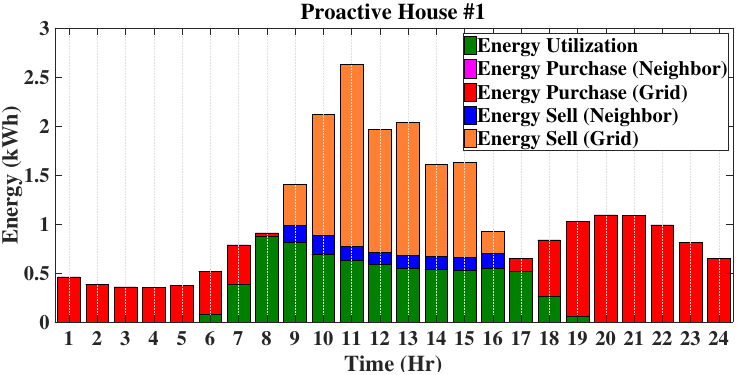
Figure 13. Energy profiles of Proactive House #1 on a typical summer